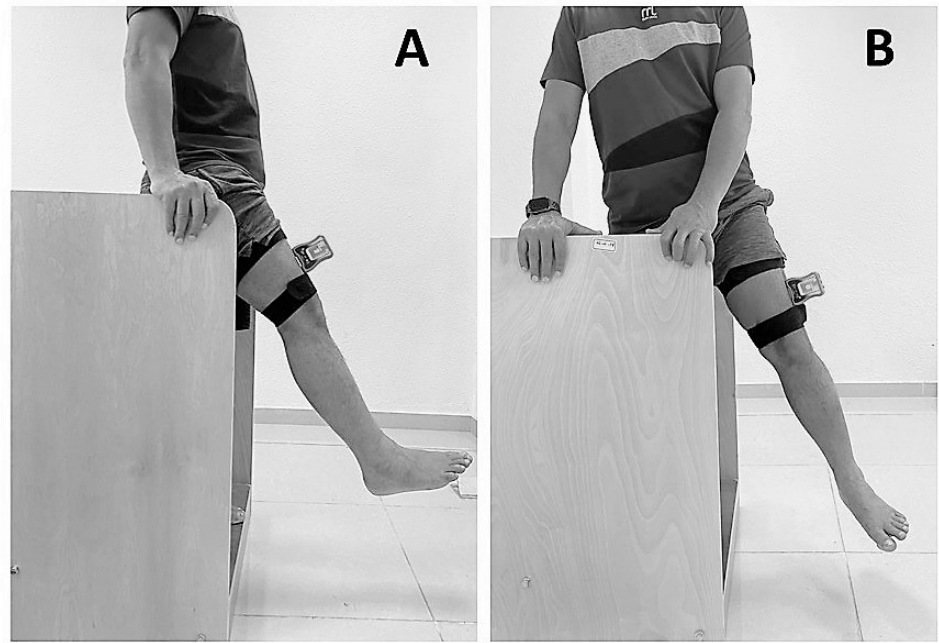
Figure 1. Assessment of hip-joint position sense in standing position ( A ) hip flexion; ( B ) hip abduc-